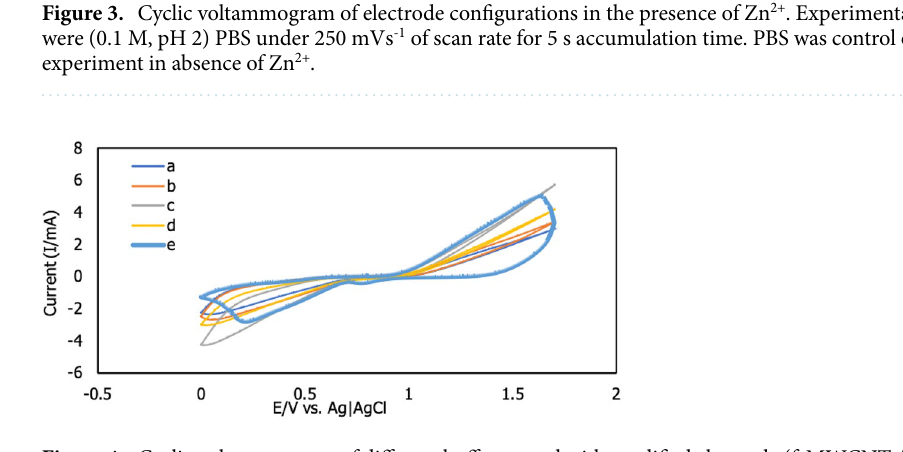
Figure 4. Cyclic voltammogram of different buffers tested with modified electrode (f-MWCNTs/CS/PB/AuE); ( a ) acetate ( b ) ammonium ( c ) citrate, ( d ) tris–HCl and ( e ) PBS buffers under scan rate of 250 mVs -1 for 5 s accumulation time in the presence of 3 ppm of Zn 2+ ( n =